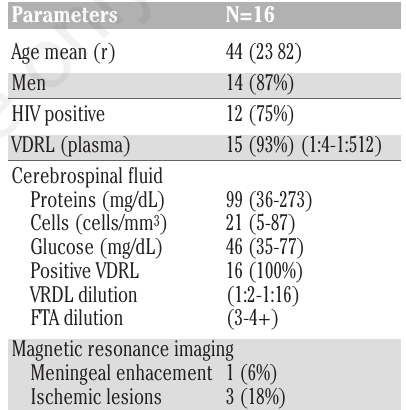
Table 1. Demographic and clinical param- eters at entry.